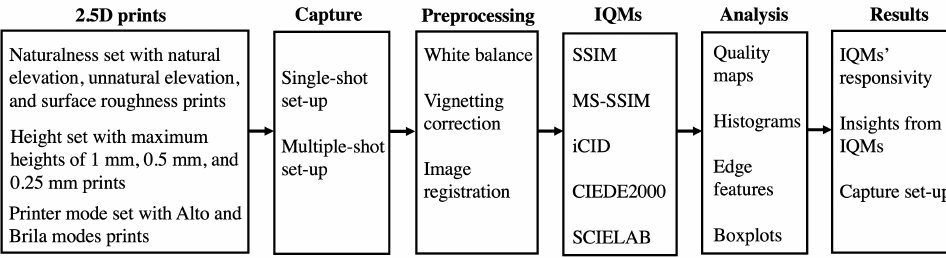
Figure 2. Our workflow. The prints are captured in the single-shot and multiple-shot set-ups, then they are processed, further IQMs are applied, before we do our analysis and report the